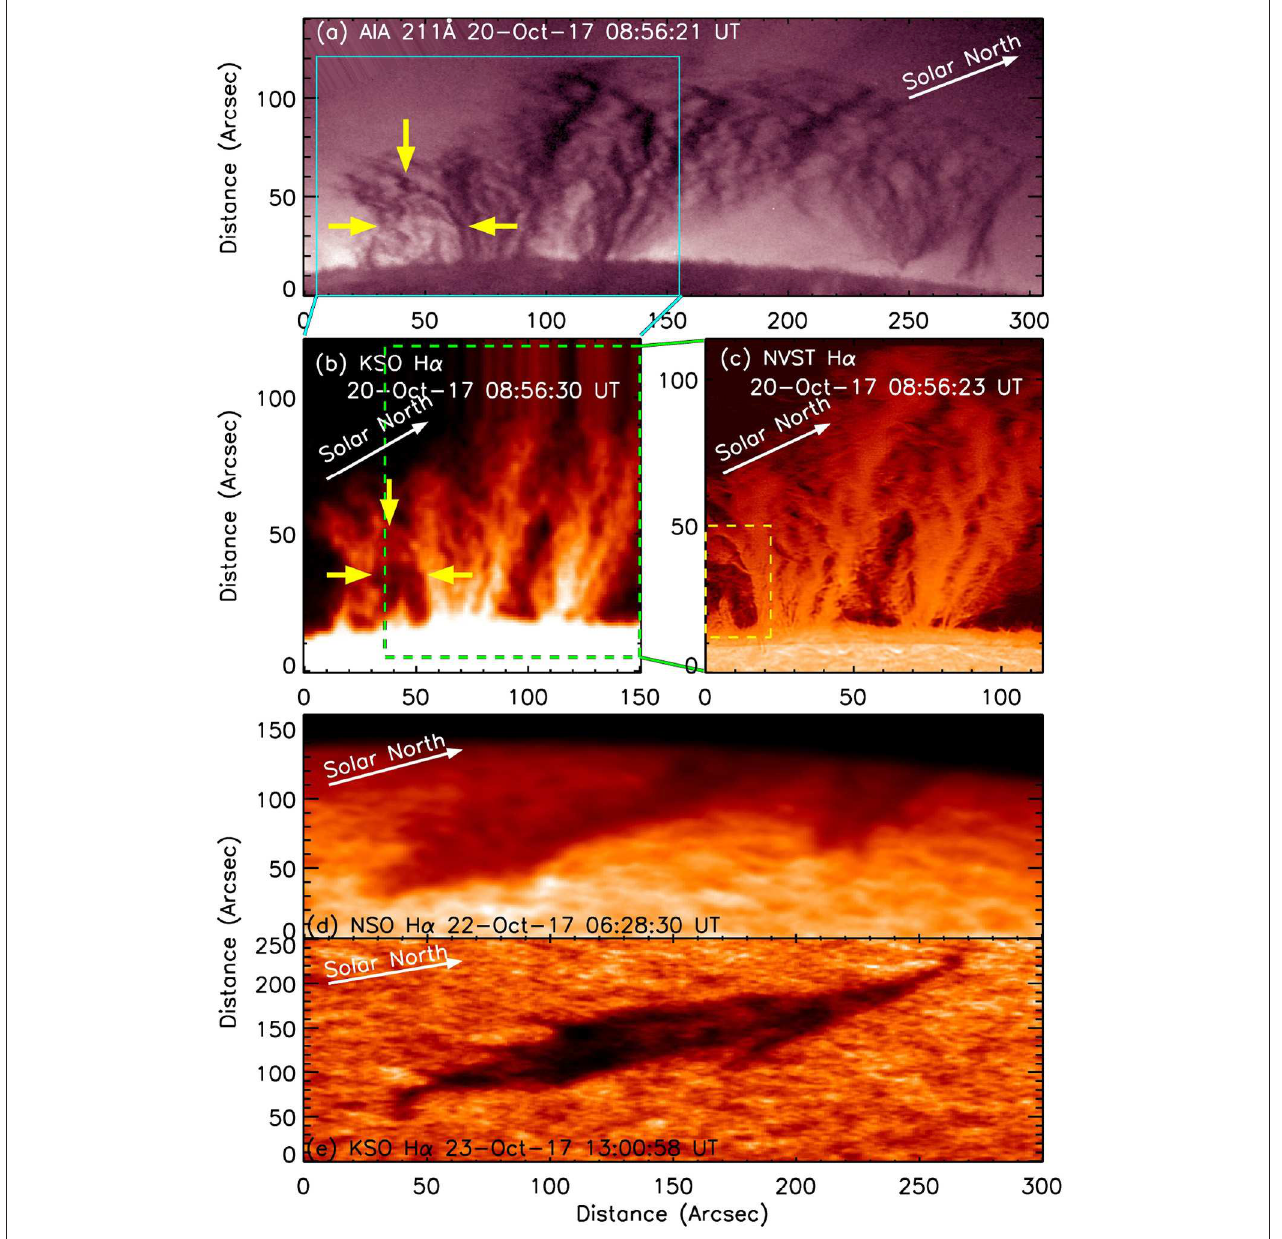
FIGURE 1 | Multi-wavelength overview of the quiescent prominence, located at the northeast limb of the solar disk on October 20, 2017 (N24E87). All the images have been rotated clockwise by 65 ◦ for presenting an upright view of the prominence. (a) AIA 211 Å image showing the entire prominence spanning across approximately 250" on the limb. The Cyan rectangle represents the field of view of the H α image acquired by the Kanzelhoehe Solar Observatory (KSO), shown in (b) . The green square region in (b) indicates the field-of-view of the H α image recorded by NVST, shown in panel (c) . Prominence bubble, investigated in this paper is outlined in yellow in (a–c) . (d,e) Prominence as observed on 22 and 23 October 2017 from the National Solar Observatory (NSO) and KSO , respectively. It is clear that the prominence morphology has not altered significantly.